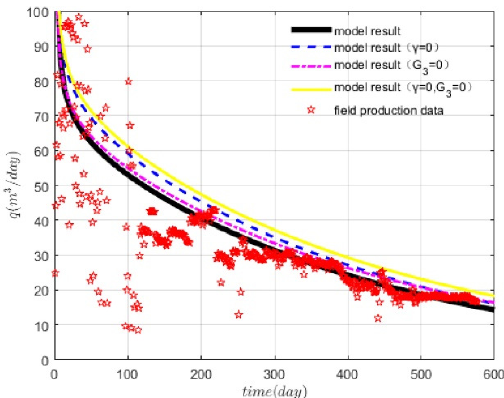
Figure 5. Model results fitted with production data. Table 2. Basic parameters of an oil well in the X Oilfield.